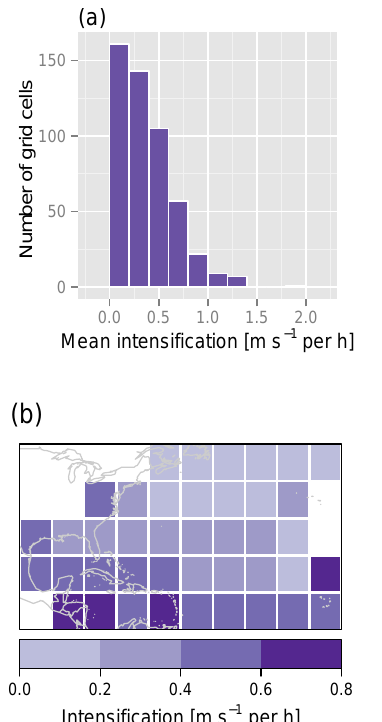
Figure 3. Mean intensification histogram and spatial plot. (a) His- togram of mean hourly intensification in 0.2ms − 1 h − 1 intervals, and (b) spatial distribution of mean intensification. The data are for the months June–October over the period